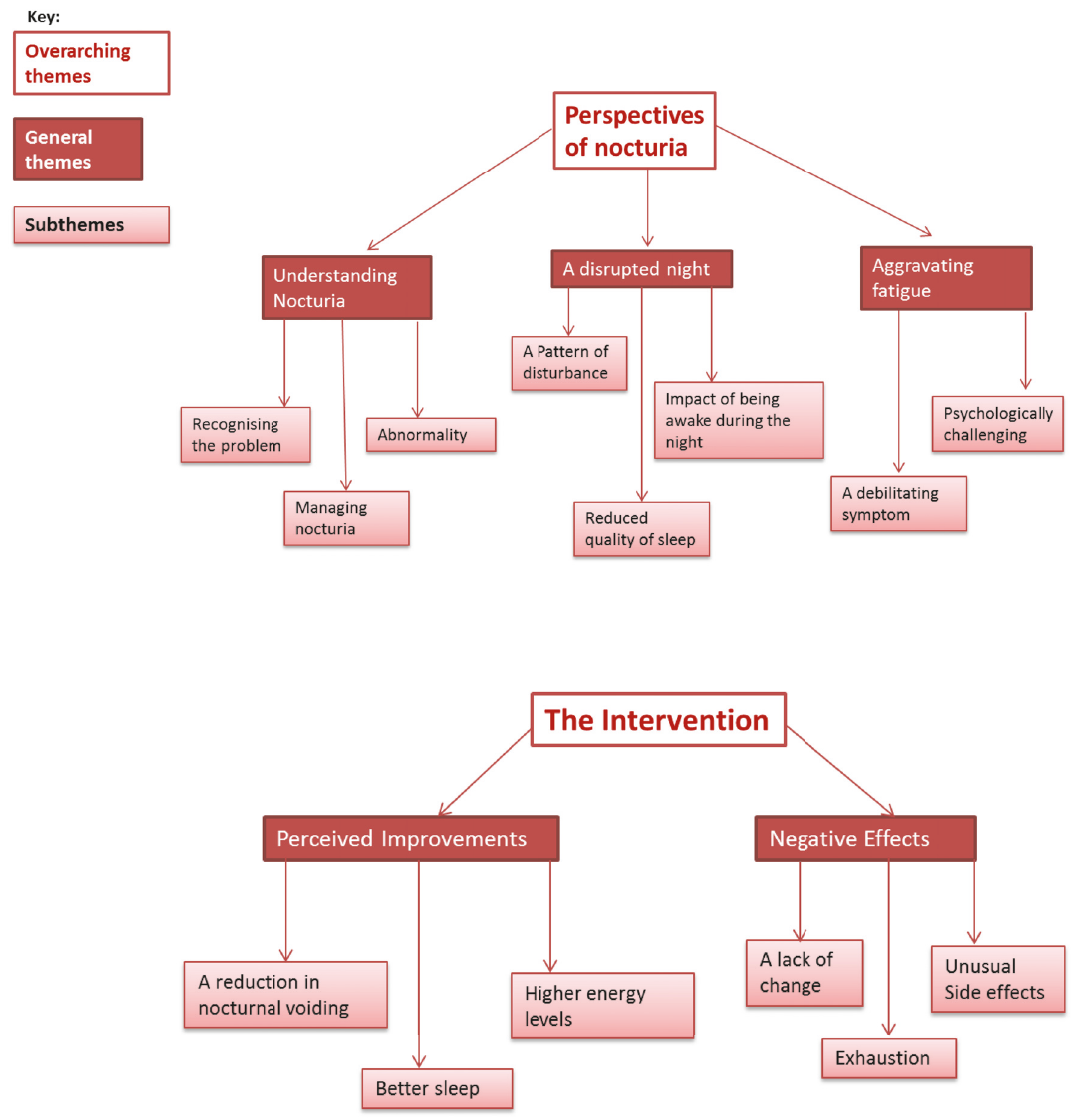
Figure 1: Summary of qualitative themes and